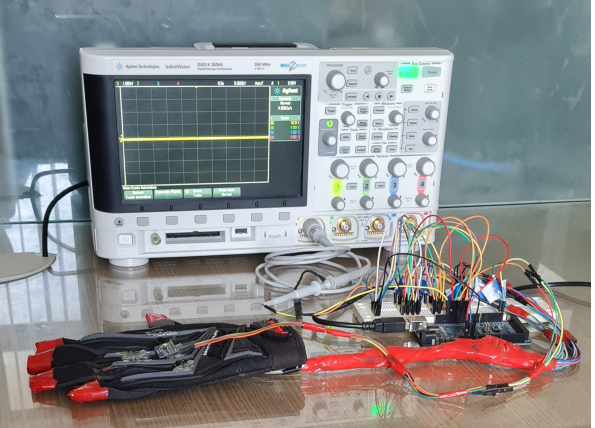
Figure 8. Configuration for viewing PWM signals related to tactile